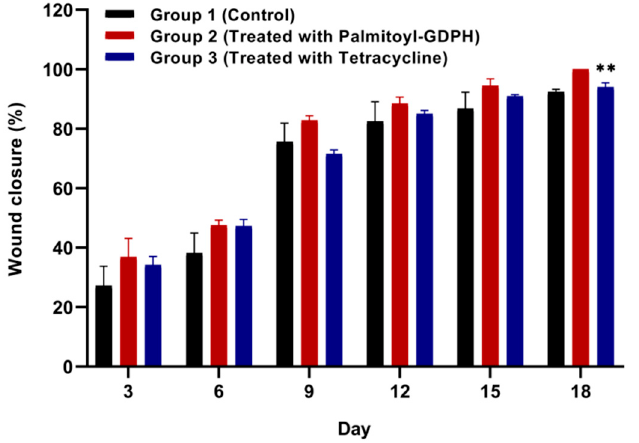
Figure 4. The percentage of wound closure for each group in different days. Data are presented as mean ± SD, n = 5. ** Significance at p < 0.01 compared with control group.